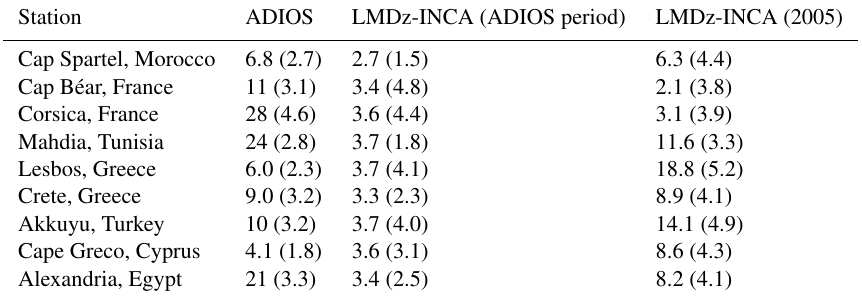
Table 2. Dust deposition fluxes (gm − 2 yr − 1 ) measured during the ADIOS campaign (derived from Al-measured deposition fluxes consid- ering that dust contains 7% of Al), simulated by the LMDz-INCA model on the ADIOS period (June 2001–May 2002) and the simulation period (2005). Values in brackets indicate the geometric SDs of monthly fluxes (same restrictions on the number of values as in Fig.